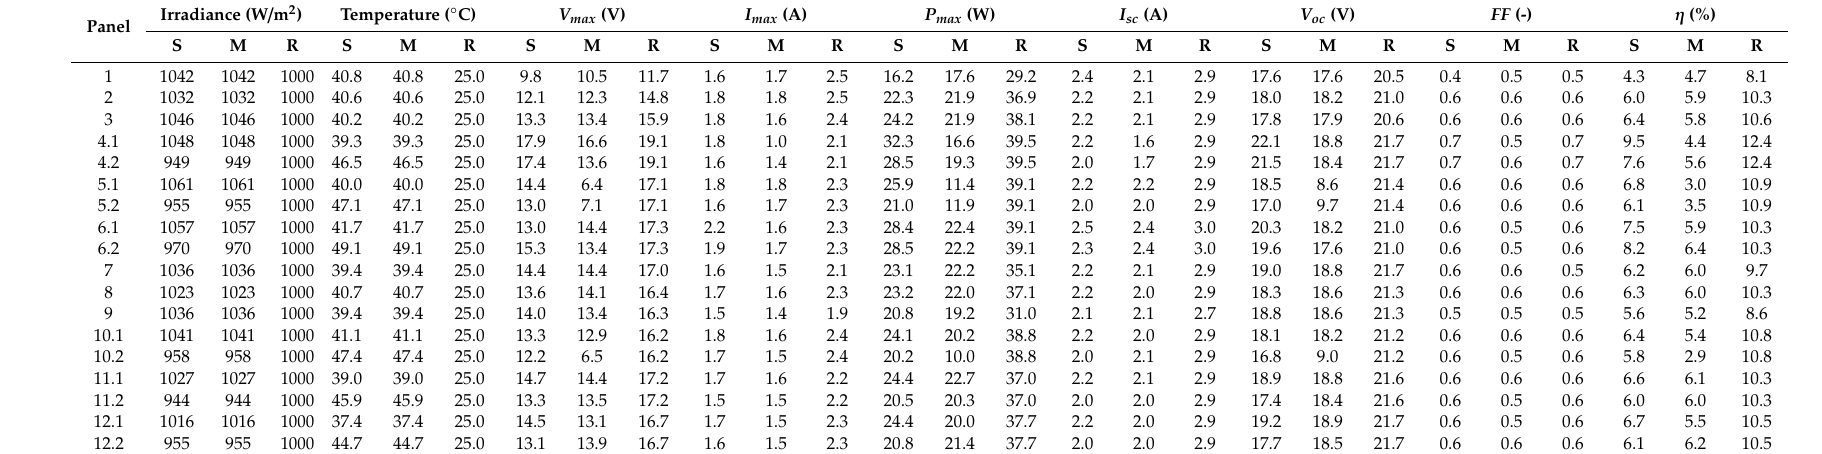
Table 2. Rating, simulation, and experimental results of each panel in the two